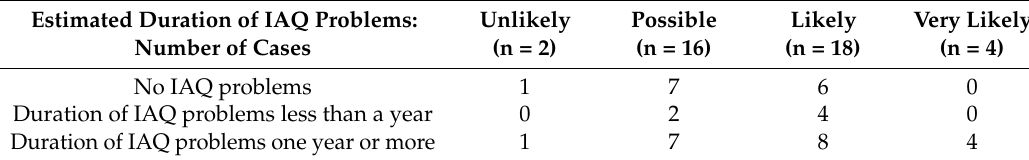
Table 7. Estimated duration of IAQ problems on each building floor or in each section